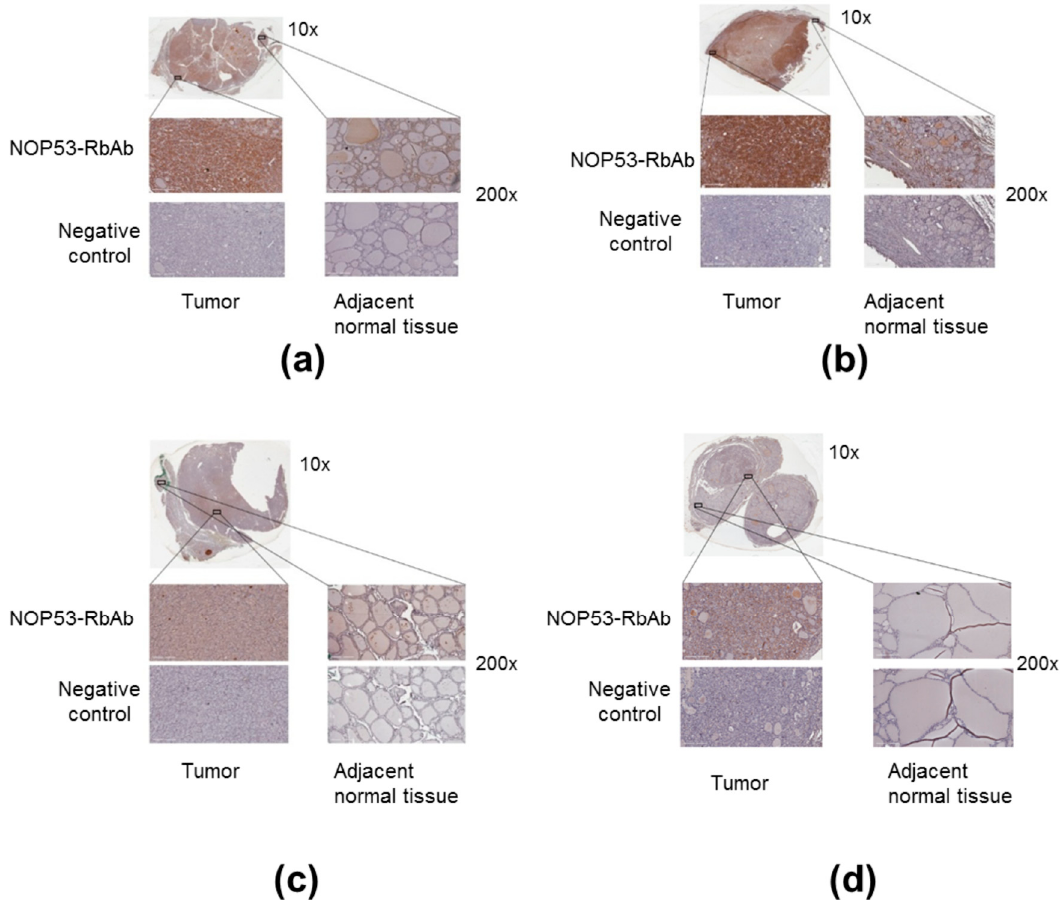
Figure 6. Overexpression of NOP53 in tumors from patients with FNMTC. Panels A through D show representative immunohistochemical staining for NOP53 in thyroid cancer samples from the four a ff ected members of Kindred 2: ( a ) Corresponds to Patient III.1.; ( b ) Patient II.2.; ( c ) Patient III.2.; and ( d ) Patient II.1. Each panel contains an inlet (zoom 10 × ); two separate regions—from tumor tissue and adjacent normal thyroid tissue—of higher magnification images (zoom 200 × ); and two higher magnification images (zoom 200 × ) from a negative control specimen at a similar location. The top left represents tumor staining with NOP53-RbAb, the top right shows adjacent normal tissue staining with NOP53-RbAb, and the two bottom images are negative controls. We observed that the tumor tissue showed a higher expression of NOP53 compared to the adjacent normal thyroid tissue in the four patients